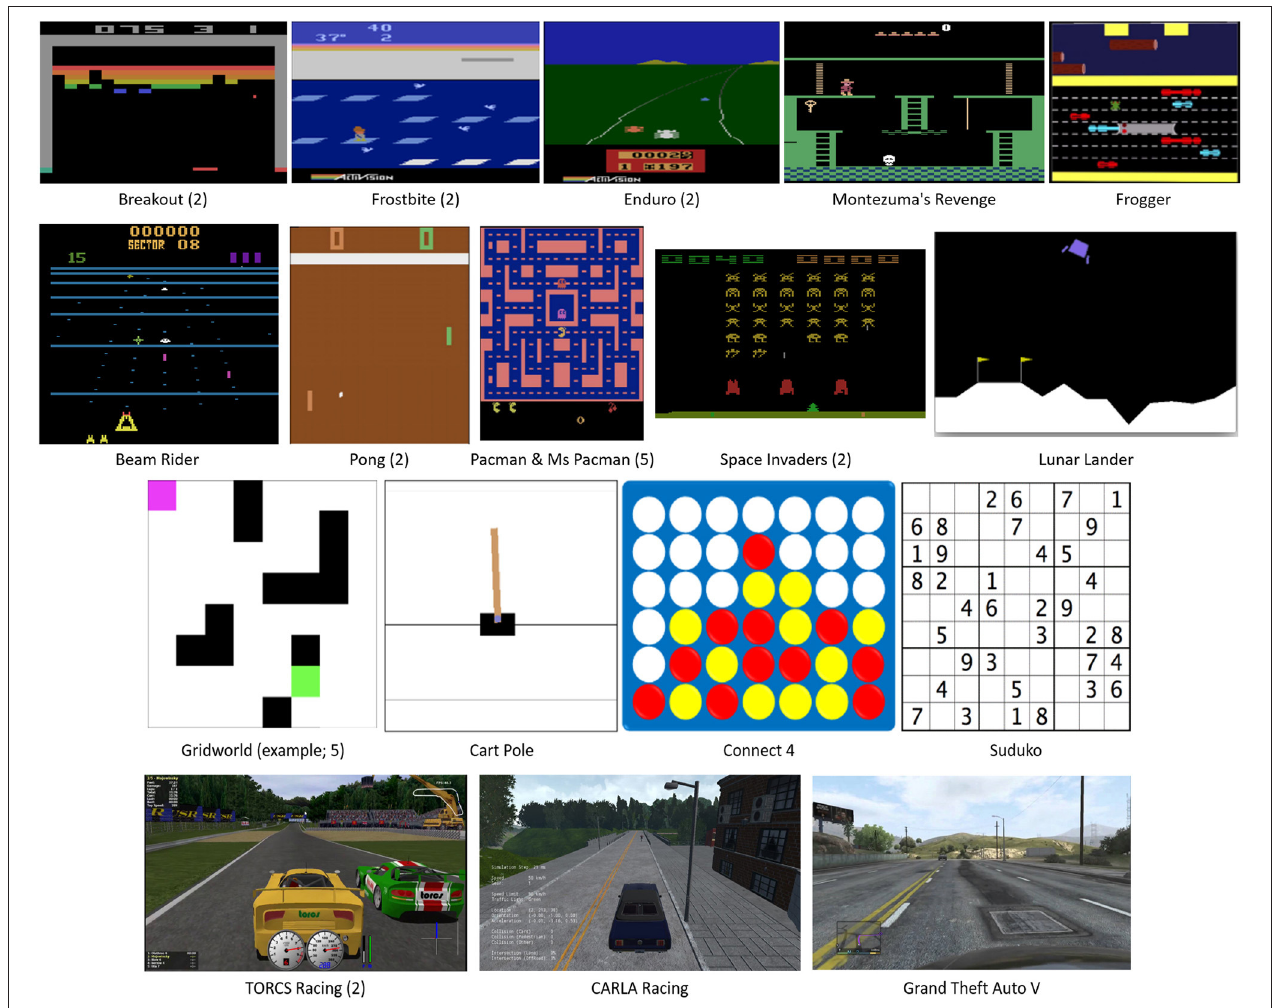
FIGURE 3 | Screenshots of the game-based applications in the studied papers. Where more than one paper used that game, the number of papers using the game are shown in